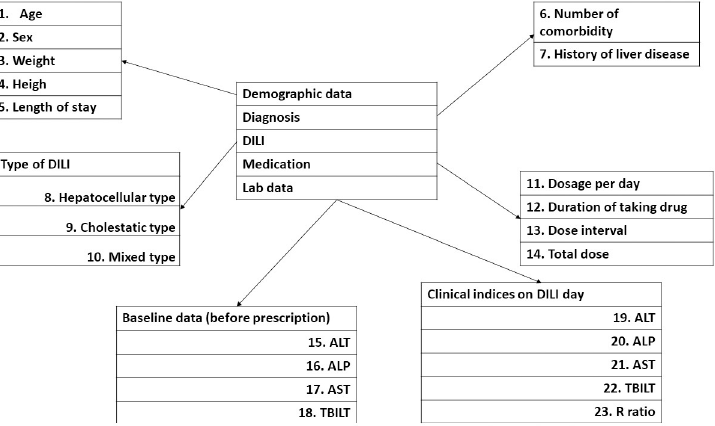
Fig 2. Variables star schema. DILI, drug induced liver injury; ALT, alanine aminotransferase; AST, aspartate aminotransferase; ALP, alkaline phosphatase; TBIL, total bilirubin.